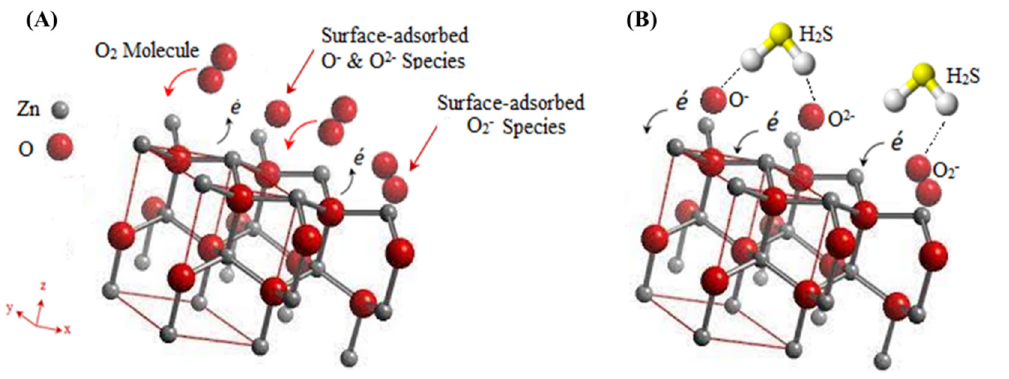
Figure 8. Mechanism of interaction between ZnO crystal lattice and O 2 molecules in air ( A ) and when flushed with H 2 S gas ( B ).